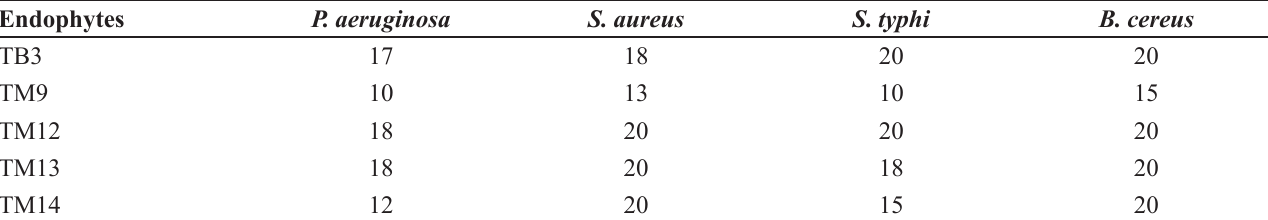
TABLE I - Antibacterial activity of the isolated bacterial strains against the human pathogenic bacteria (Zone diameter in mm)